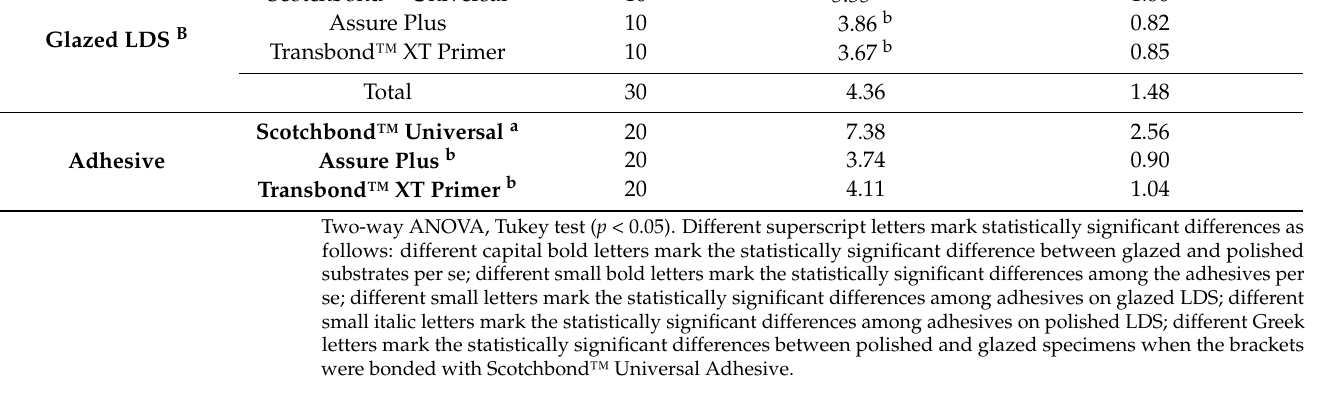
Table 4. Descriptive statistics of shear bond strength data of monolithic zirconia (MZ)